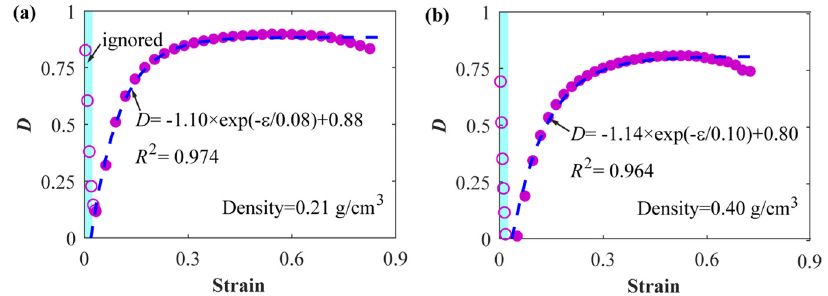
Figure 7: The variation laws of damage ( D ) of the TFPU grouting materials with di ff erent densities with strain under uniaxial compression: TFPU samples are included in Figure S2. When D was stage ( Stage II ) of the stress – strain curves.